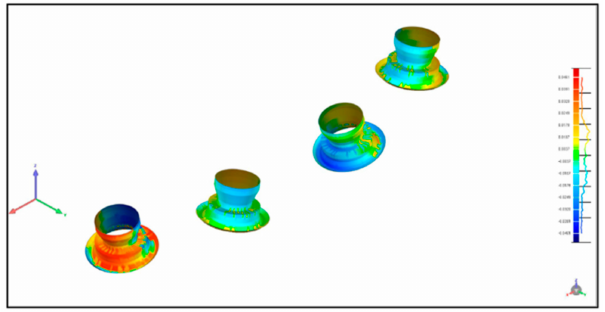
Figure 5. STL files of the different groups overlapped using the Geomagic software (Geomagic Qualify 12, 3D Systems, Rock Hill, SC, USA), facilitating the calculation of 3D deviations between the master model data and the different